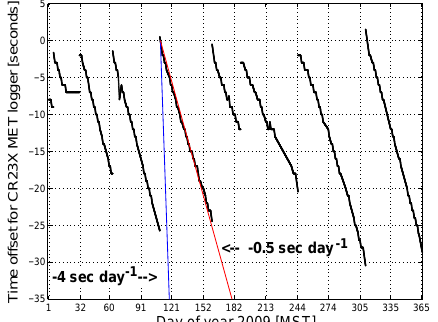
Figure 7. Time series of the estimated time offset between the CR23X MET data logger clock and the data system clock in 2009 (a negative offset indicates that the MET logger time lagged behind the data system time). The offset is calculated based on the time of the LI-6262 calibration, which is controlled by the MET data logger and programmed to occur every 4h, starting at midnight. On aver- age, the drift in the CR23X clock was approximately − 0.5sday − 1 . The blue line indicates the CR23X worst-case clock drift specifica- tion of − 4sday − 1 (i.e., − 2minmonth − 1 for temperatures between − 40 and − 25 ◦ C), while the red line corresponds to a clock drift of − 0.5sday − 1 . The sharp jumps back toward zero occurred when the CR23X clock was manually reset during site visits.